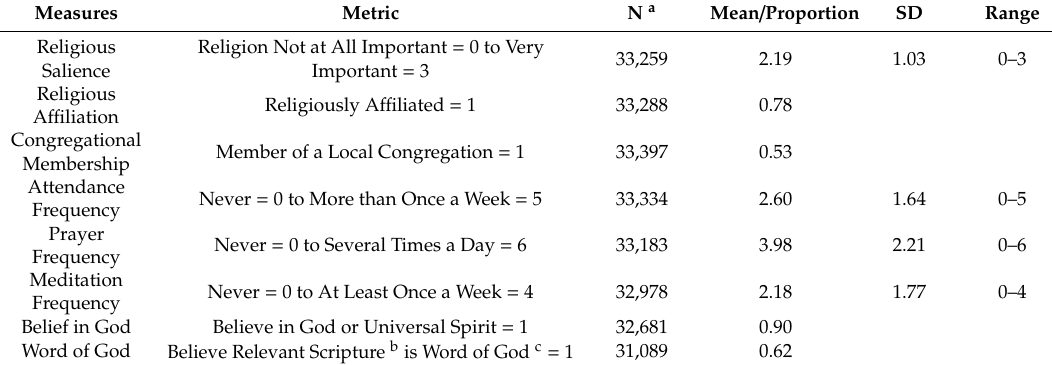
Table 2. Metrics and descriptive statistics for religion